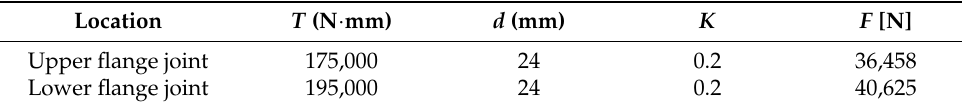
Table 3. Data used to calculate the bolt pretightening